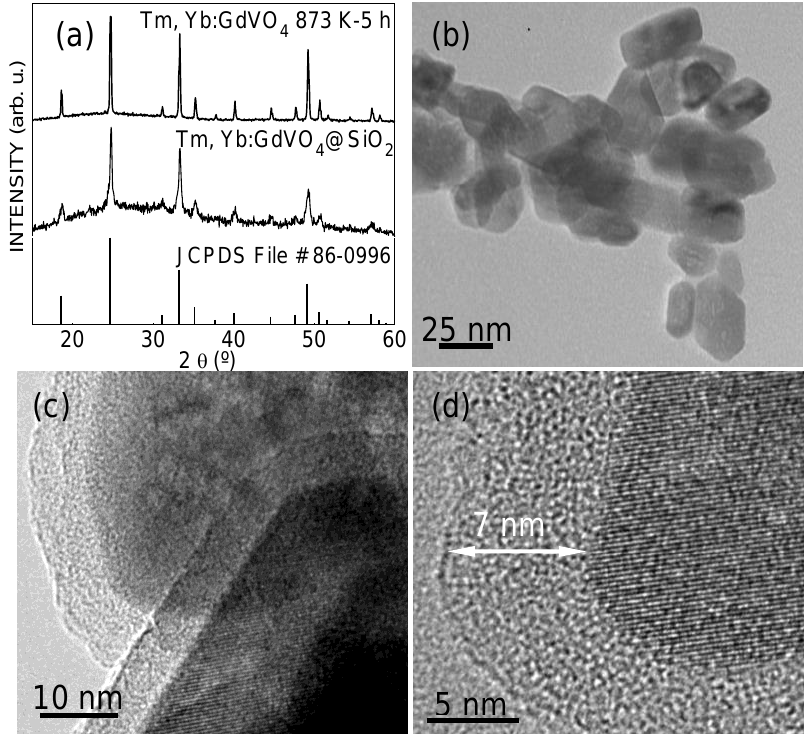
Figure 1. Structural and morphological characterization of Tm,Yb:GdVO 4 nanoparticles. ( a ) X-ray di ff raction patterns of the Gd 0.84 Yb 0.15 Tm 0.01 VO 4 sample annealed at 873 K for 5 h, and coated with a 7 nm thick SiO 2 layer. For comparison, the X-ray di ff raction (XRD) pattern scheme of tetragonal I 4 1 / amd GdVO 4 , Joint Committee on Powder Di ff raction Standards (JCPDS) File 86-0996 has been also included. ( b ) Transmission electron microscope (TEM) image of the annealed Tm,Yb:GdVO 4 nanoparticles (NPs). ( c ) and ( d ) Hig-resolution transmission electron microscope (HRTEM) images of core-shell Tm, Yb:GdVO 4 @SiO 2 NPs, showing the lattice fringes of the crystalline core (darker areas) and the amorphous silica shell (lighter areas around the core).